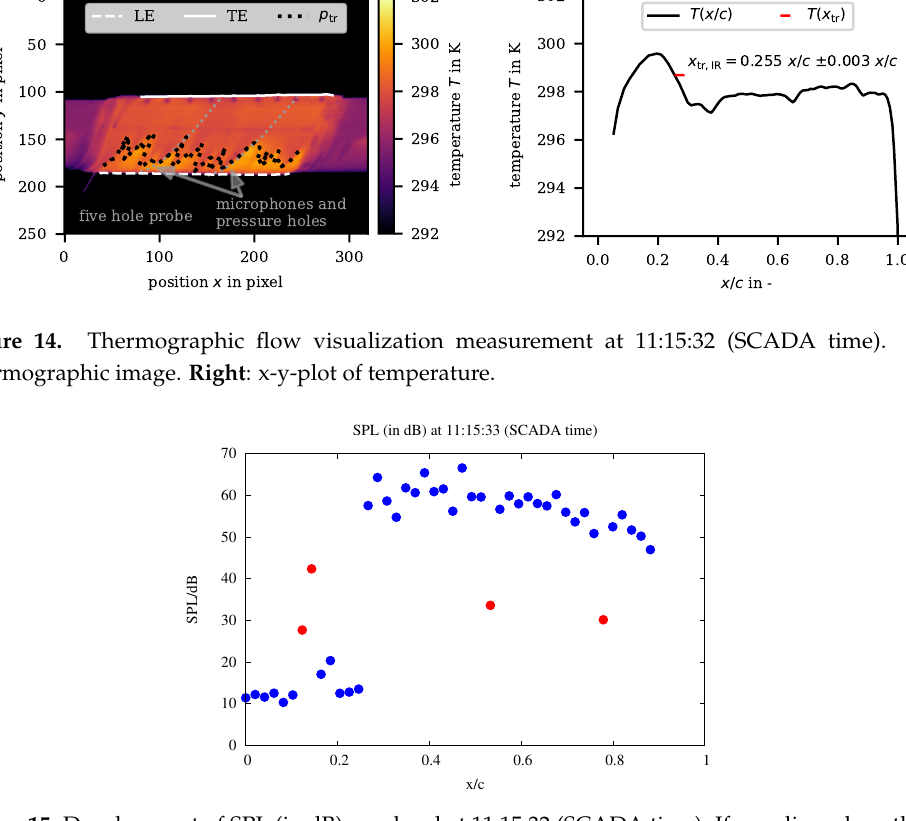
Figure 15. Development of SPL (in dB) vs. chord at 11:15:32 (SCADA time). If one discards outliners (in red) x tr, M / c , may be deduced to x tr, M / c = 0.26 ±